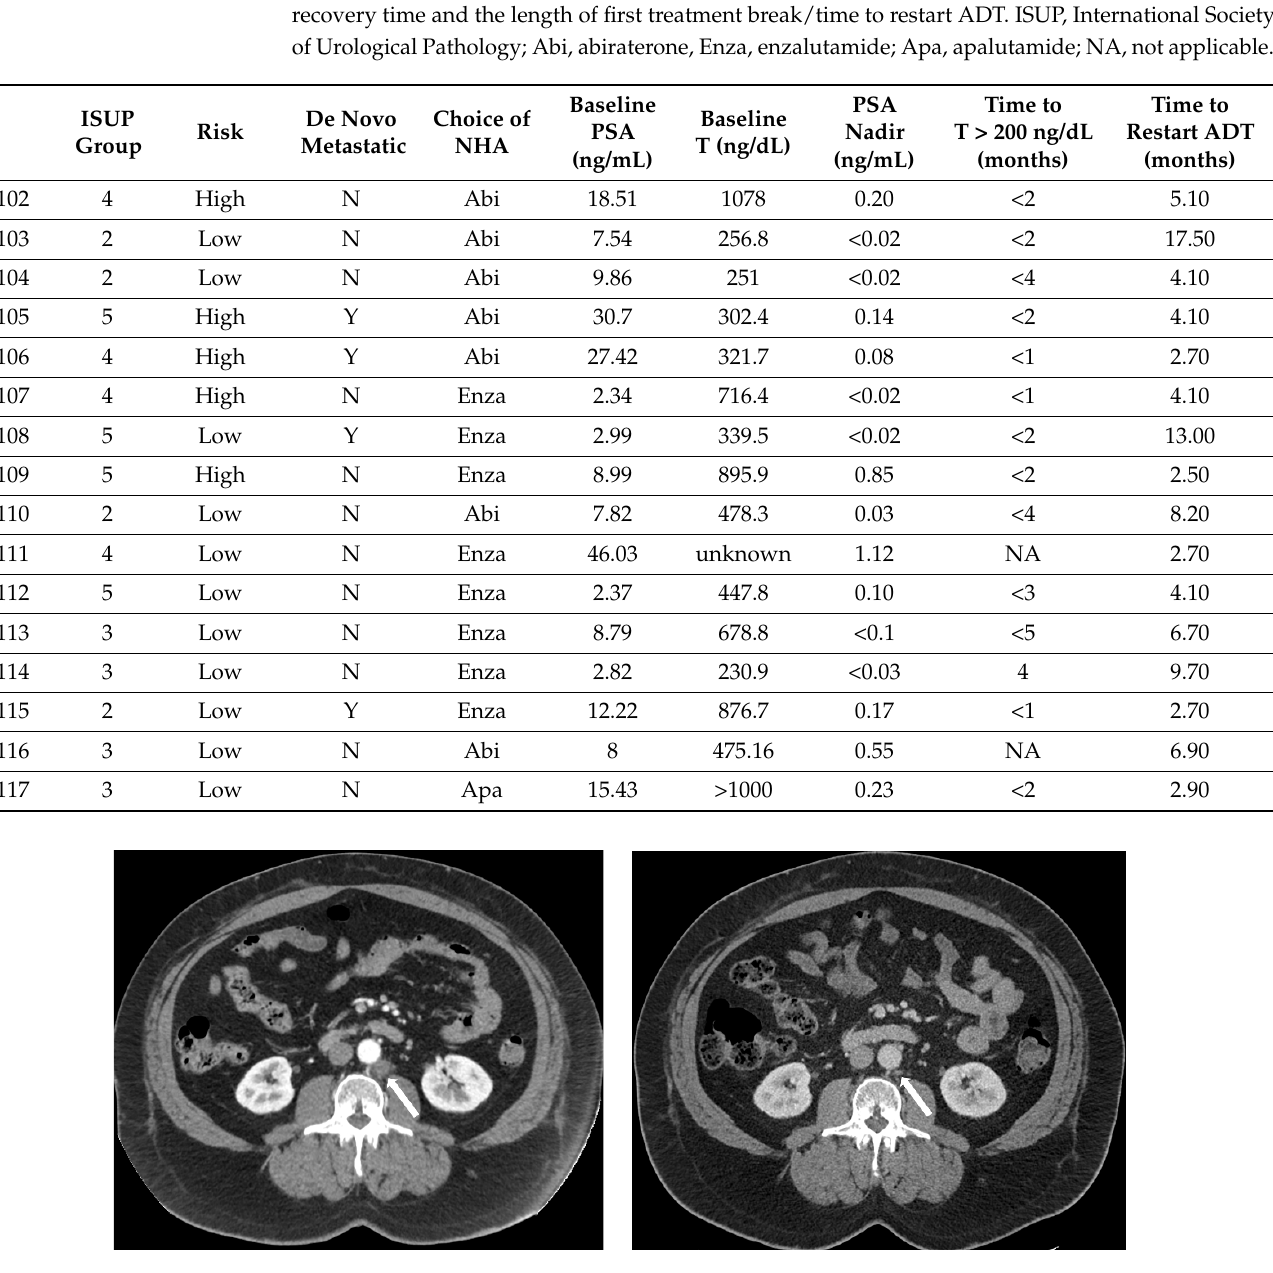
Figure 2. CT images of a retroperitoneal lymph node (white arrow) that has reduced from 1.53 × 1.62 cm ( left ) to 0.40 × 0.60 cm ( right ) after induction ADT in subject 103. As shown in Figure 3, only two (102, 107) of the 16 enrolled patients developed on treatment radiographic progression and both patients progressed at 28 months from their first dose of LHRH analog for mCSPC. Cell-free tumor DNA (ctDNA) tests at the time of imaging progression showed AR T878A mutation in subject 102 and AR amplification in subject 107. Four subjects had developed on treatment PSA progression at months 12.4